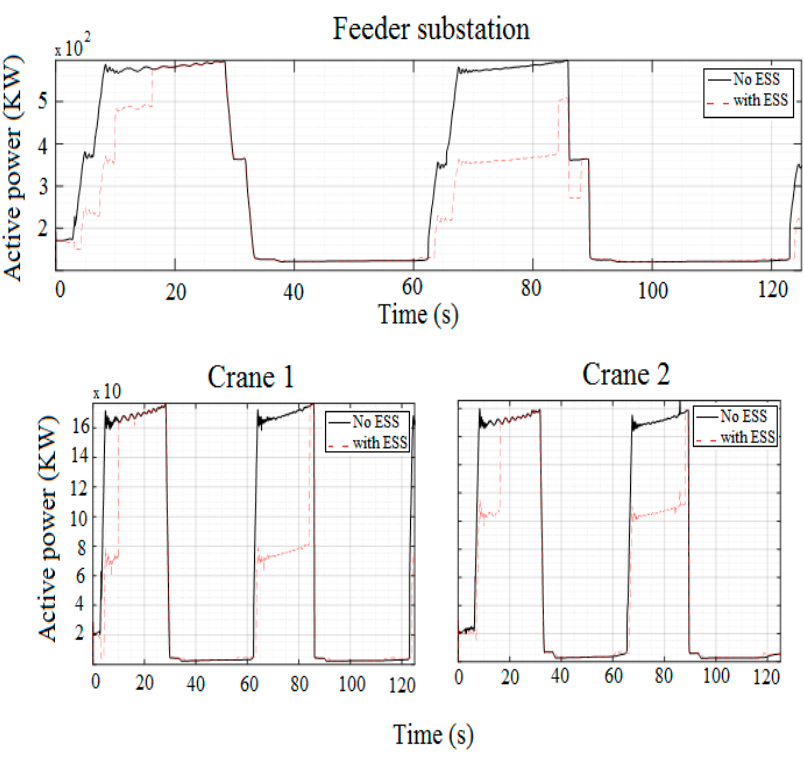
Figure 7. An example for the power flow of network of two RTG cranes without (black line) and with (red line) the energy storage system.